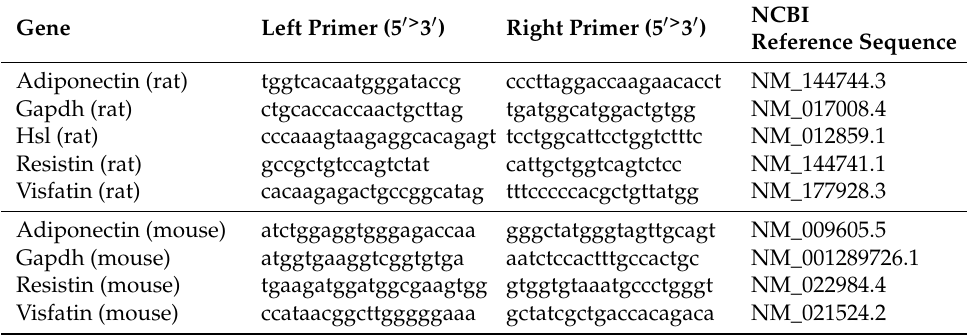
Table 1. Primer sequences for real-time